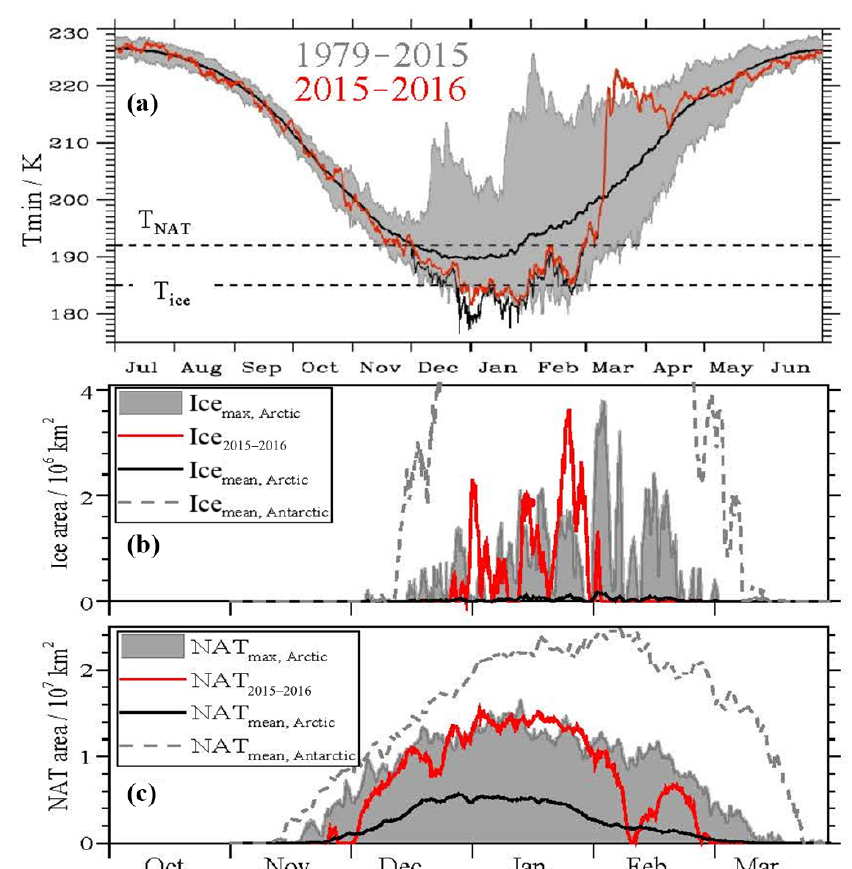
Figure 1. Temperature evolution of the 2015–2016 Arctic winter stratosphere (a) 6-hourly ECMWF ERA-Interim reanalysis (Dee et al., 2011) data retrieved at a horizontal resolution of 1 ◦ : minimum temperature T min (K) between 65 ◦ and 90 ◦ N at the 30hPa pressure surface. The thick black line denotes the mean values of T min averaged during 1979 to 2015, and the shaded areas encompass the minimum and maximum values of T min between 1979 and 2015. The red line marks the evolution of T min from operational analyses of the IFS cycle 41r1 until 8March 2016. The thin black line indicates T min from the IFS cycle 41r2 in the pre-operational phase from 1 December 2015 to 8 March 2016, retrieved at a resolution of 0.125 ◦ . After 8 March 2016, the black line continues as red curve of the operational IFS cycle 41r2. T ice (Murphy and Koop, 2005) and T NAT (Hanson and Mauersberger, 1988) are calculated using 4.6ppmv H 2 O and 7ppbv HNO 3 , relevant for the 2015–2016 Arctic vortex conditions (Manney and Lawrence, 2016). (b) Evolution of the vortex area with temperatures below T ice . The black line marks the mean area below T ice ( A ice ) at 30hPa pressure ( ∼ 21 . 6km) between 1979 and 2015. The grey shading indicates maximum and minimum A ice in the same time period. The red line shows the evolution of A ice at the 30hPa pressure surface in the Arctic winter 2015–2016 of the IFS cycle 41r2. The grey dashed line gives the mean area below T ice at 30hPa south of 65 ◦ S from 1979 to 2015, shifted by 6 months to account for seasonality. (c) Same data for